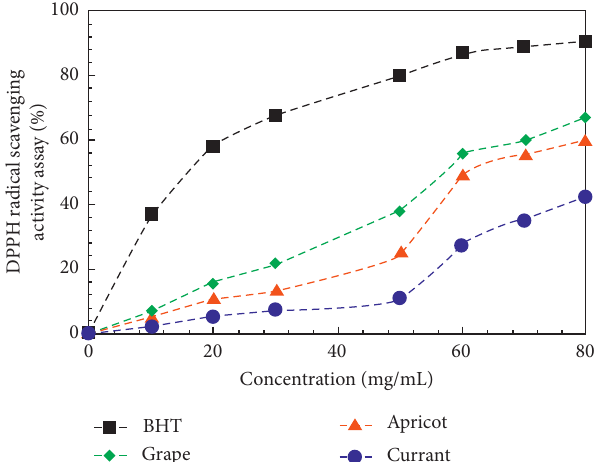
Figure 8: DPPH radical scavenging activity of the aqueous black currant, apricot, and grape pomace extracts.